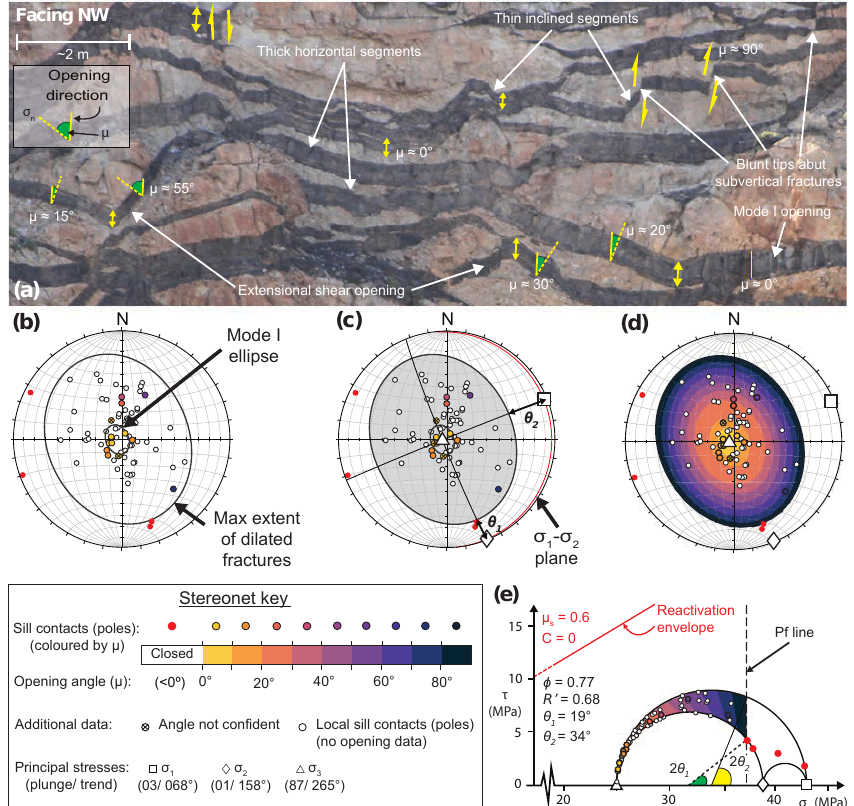
Figure 7. The opening-angle mechanical model. (a) Field example of thin sills ( < 1m thick) displaying a range of local contact dips and a consistent vertical opening. (b) Lower-hemisphere, equal-area stereonet with local sill contacts plotted as poles to planes, coloured relative to their opening angle, with Mode I and total dilational ellipses constructed. (c) Determination of principal stress axes and θ angles. (d) Mechanical model results using the stress ratio and driving pressure ( φ = 0.77, R (cid:48) = 0.68; see text for details) derived from panel (c) . (e) 3-D Mohr circle showing how θ 1 and θ 2 can be used to calculate relative fluid pressure; the Mohr circle is colour contoured for values of µ ; local sill contacts are plotted as poles and coloured by their opening